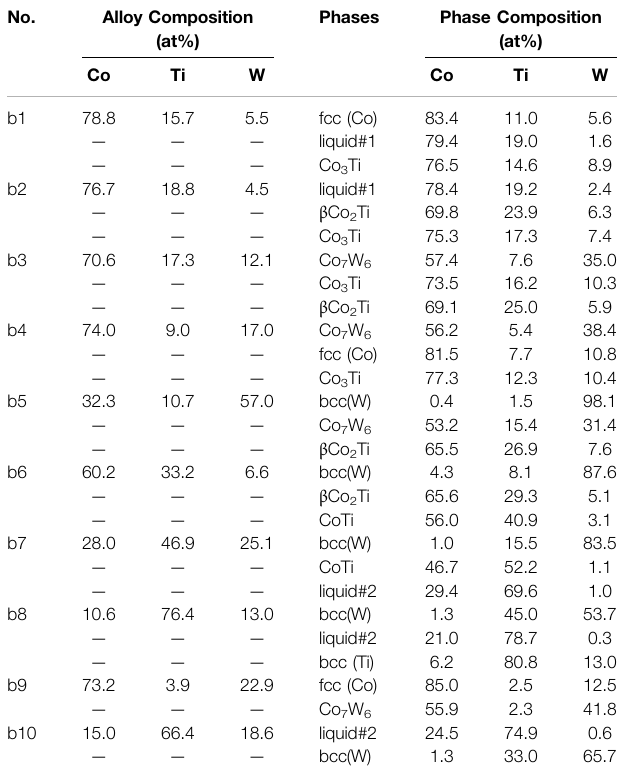
TABLE 3 | The constituent phases and their compositions of the Co – Ti – W alloys annealed at 1473